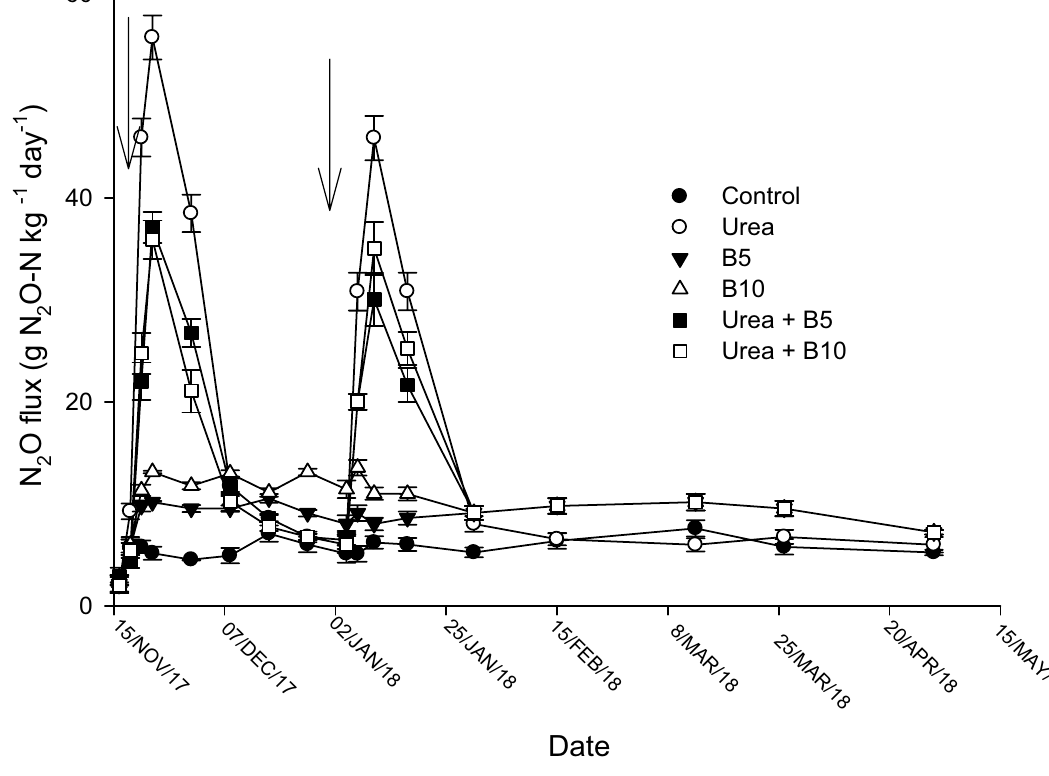
Figure 3. Fluxes of N 2 O. in soils amended with sole urea or urea + biochar treatments. Solid arrows show time of N fertilization.